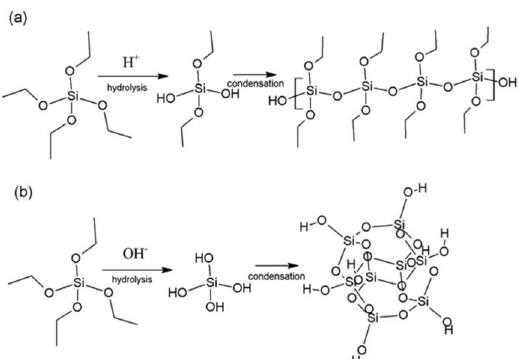
Figure 2.. Schematic representation of the sol-gel reaction using (a) acid and (b) basic catalyst.